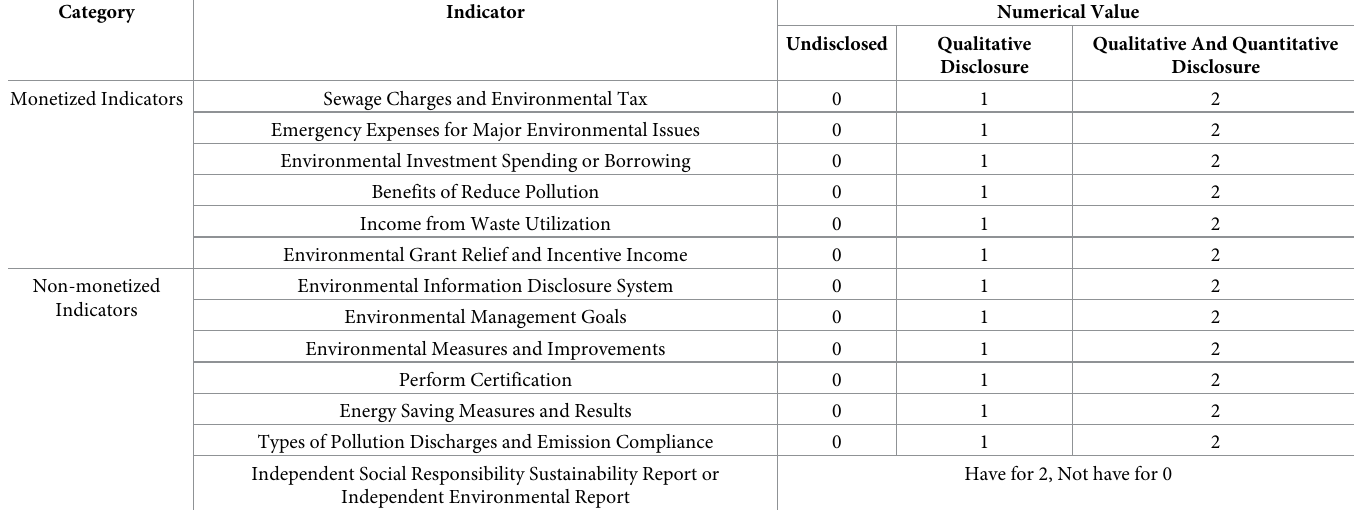
Table 1. Measures of EID indicators.